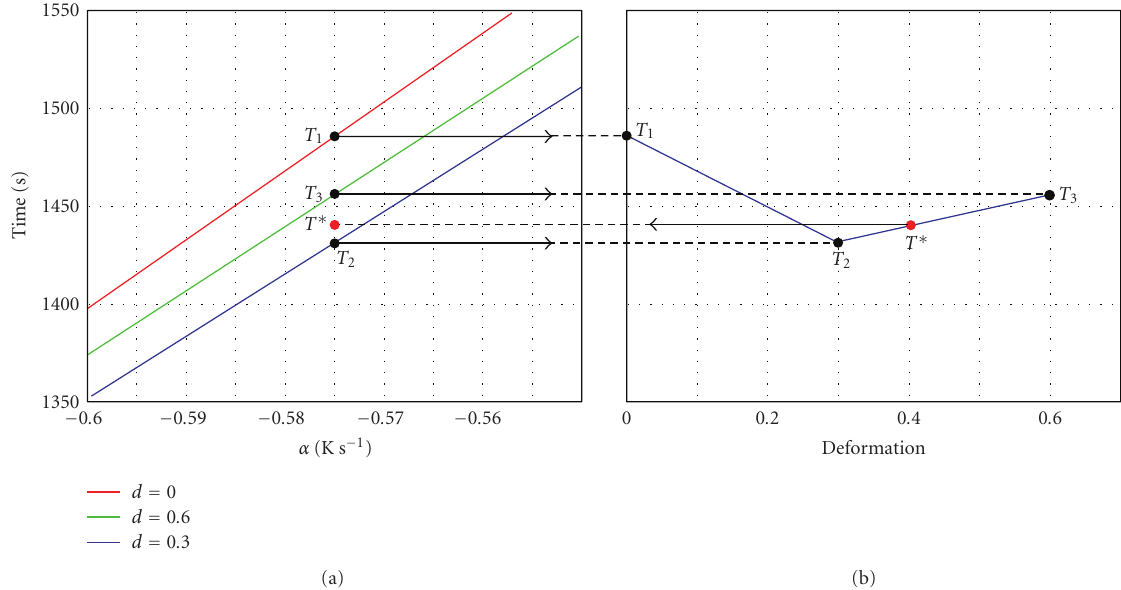
Figure 6: (a) Curves of martensite initiation temperature in the ( α , time ) coordinate system. (b) Scheme of linear data extension.